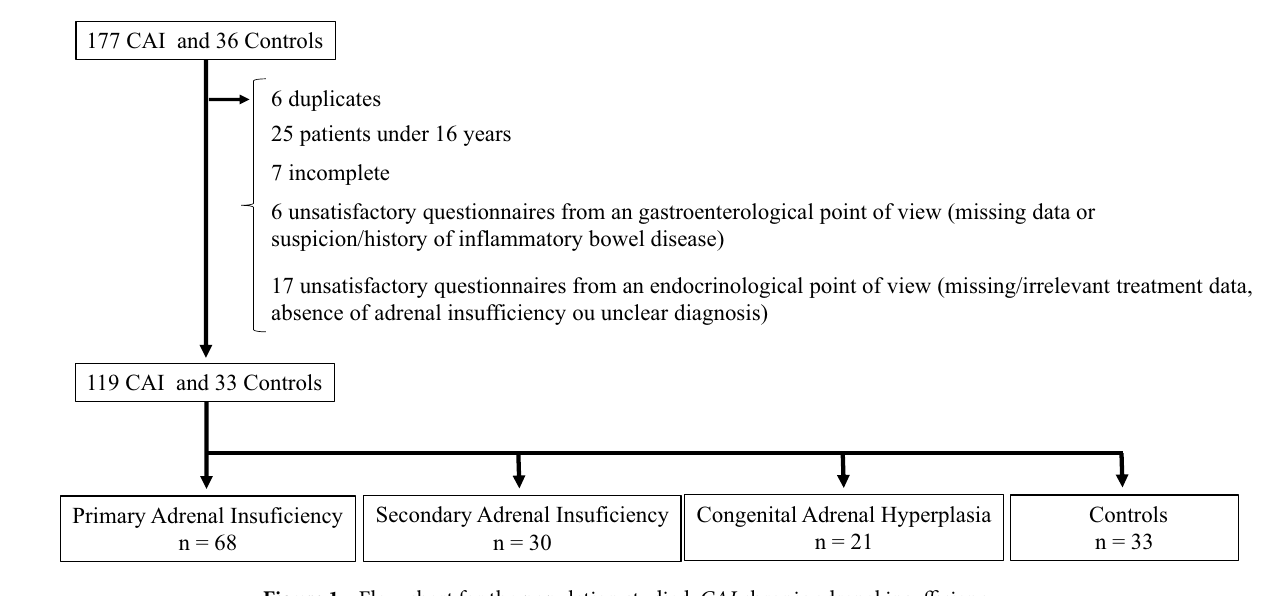
Figure 1. Flow chart for the population studied. CAI chronic adrenal